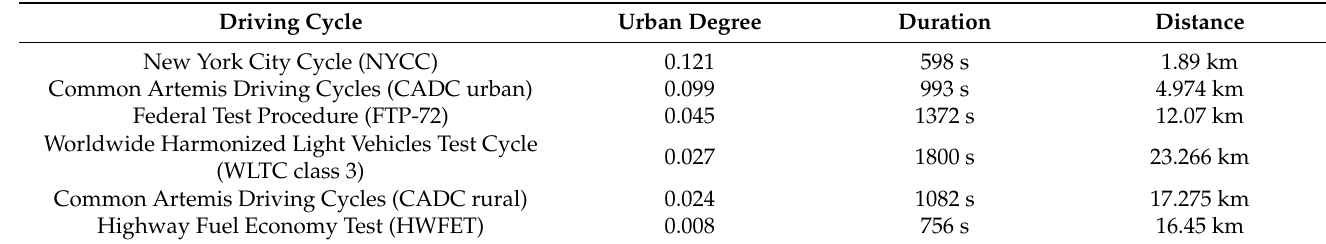
Table 2. Driving cycles considered for the assessment and comparison of the different control algorithms